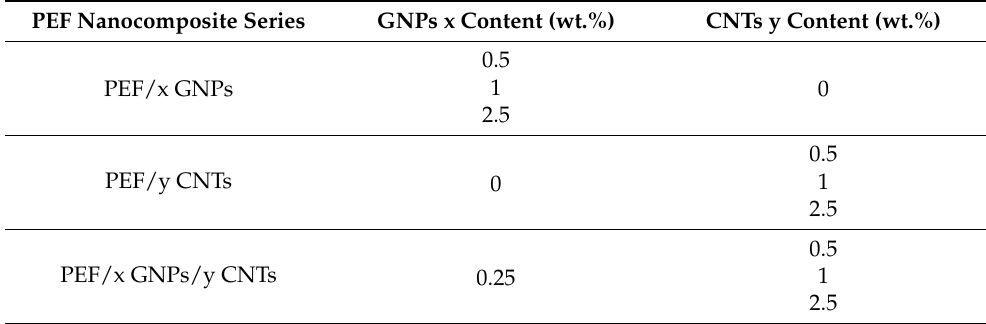
Table 1. PEF nanocomposites fillers’ content and their given names in this work. PEF Nanocomposite